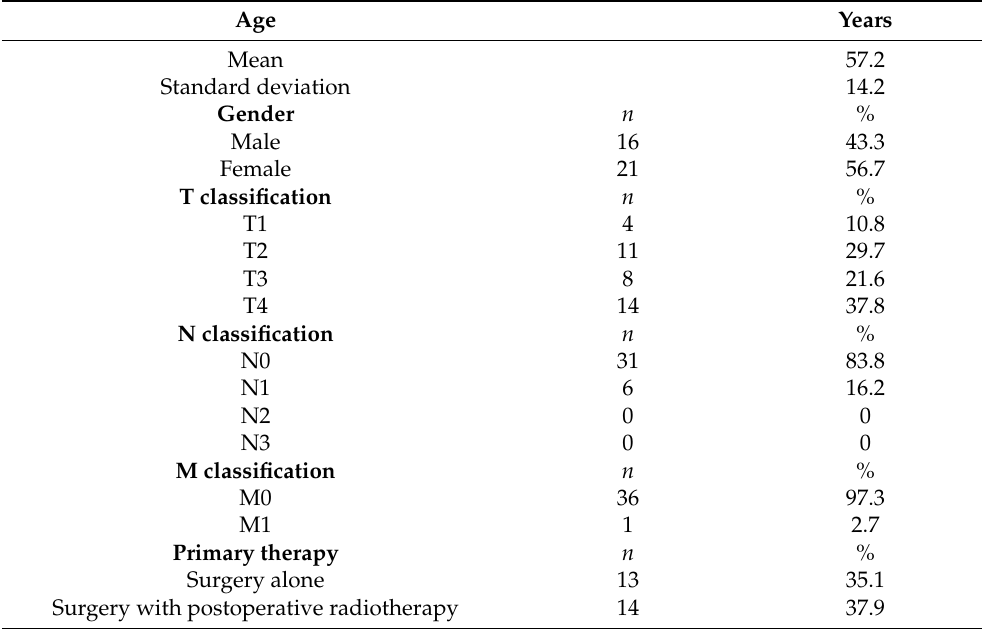
Table 1. Patient and tumor characteristics including treatment